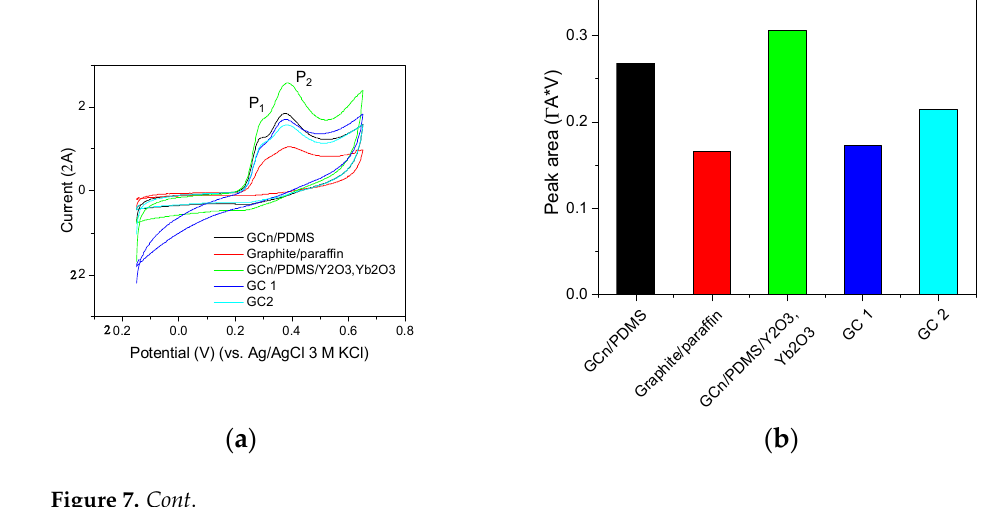
( d ) Figure 7. ( a ) Cyclic voltammograms recorded in 5 µM solution of epigallocatechin using paste (GC n /PDMS, graphite/paraffin, GC n /PDMS modified by Y 2 O 3 , Yb 2 O 3 ) and glassy carbon disk (2 mm in diameter, two batches: GC 1 and GC 2) electrodes. ( b ) The area of peaks P 1 and P 2 shown in Figure 7a. ( c , d ) Two subsequent cyclic voltammograms recorded in 5 µM solution of epigallocatechin gallate using ( c ) GC n /PDMS and ( d ) GC 1 electrodes. Supporting electrolyte: 0.1 M acetate buffer, pH = 4.5. Scan rate 50 mV/s. 3.6. Application of GC n /PDMS Electrodes for the Determination of Antioxidant Capacity of Herbal Extracts The next stage of the research was the application of GC n /PDMS electrodes for the examination of catechins contained in herbal extracts. Opening experiments were carried out in solutions obtained during a 10-min extraction of the Camellia sinensis (green tea, GT1) sample with water at 95 ° C, using 0.15 g of tea leaves and 100 mL of water. The voltammograms of samples diluted 20 times in 0.1 acetate buffer showed two well-shaped oxidation peaks, P 1 and P 2 , and a poorly developed reduction peak, P 3 , (Figure 8, black voltammograms) that indicated the presence of epigallocatechin gallate in the sample. Subsequent experiments were aimed at determining whether the sensitivity of the electrodes would be sufficient to track changes in catechins concentration during the storage of tea extracts under various conditions. As can be seen from the voltammograms shown in Figure 8, the GC n / PMDS electrode allows tracking of catechins concentration changes caused by temperature, exposure to sunlight, and oxygen access. The recorded voltammograms confirm that solutions exposed to oxygen and sunlight lose their antioxidant properties very quickly (Figure 8d). When access to oxygen is limited, changes occur much more slowly. The high sensitivity and capability of GC n /PMDS to provide well-developed catechins signals make it possible to observe subtle changes in the composition of examined extracts caused by photochemical reactions. This is indicated by a comparison of the voltammograms recorded after six days of storing the extracts in the dark and in the presence of sunlight. Two peaks P 1 and P 2 are visible on the